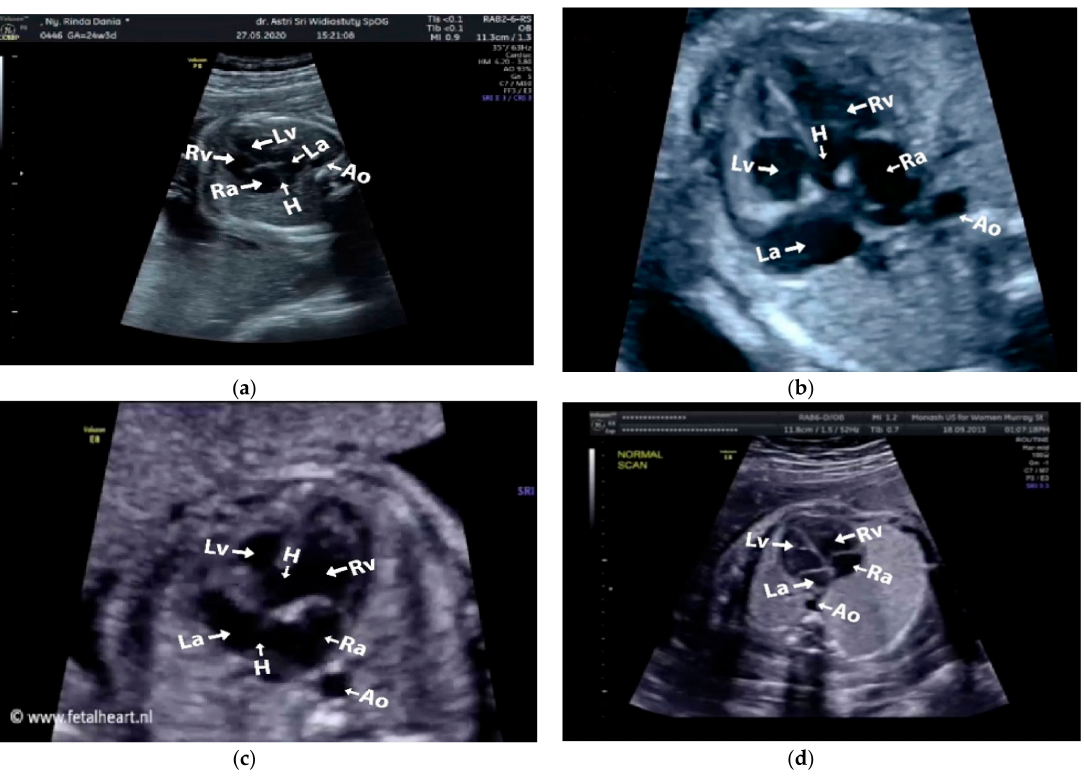
Figure 3. Fetal heart scan in 4CH view for CHDs detection: ( a ) ASD; ( b ) VSD; ( c ) AVSD; and ( d ) Normal. Especially for heart defect detection, only 4CH view was used to analyze ASD, VSD, and AVSD images. Annotated images indicate the position of defect in the atrium, ventricle, or both of them. Figure 4 depicts the sample of annotated images for a standard view of 4CH, 3VT, LVOT, and RVOT, and Figure 5 shows the sample annotated images of defect position in ASD, VSD, and AVSD. Finally, the whole annotated images are labelled as the ground truth database, and it was saved in the JSON file format (json).